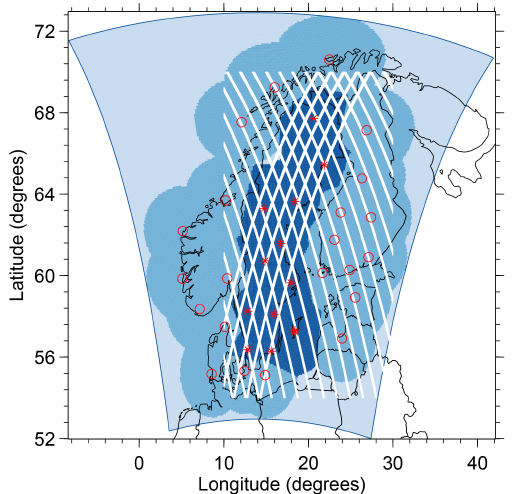
Figure 1. Area covered by the Nordrad composite (light blue). Cov- erage by all Nordic radars is shown in blue. Data originating from Swedish radars (Swerad) are displayed in dark blue. The positions of the Swedish radars are depicted by red stars, whereas the loca- tions of the other radars are shown by red circles. Tracks of the selected CloudSat passes are illustrated by white lines.